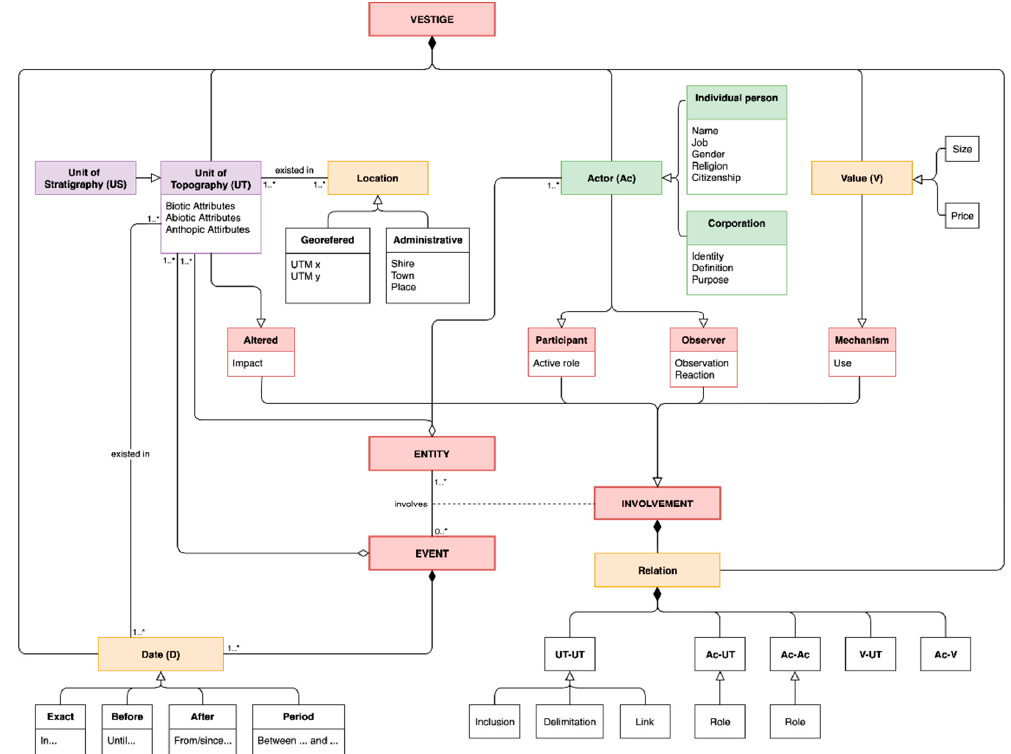
Figure 2. UML diagram expressing the minimum information units of historical knowledge as components of Vestige. This conceptual modeling fits well within Thibodeau’s CPT, whose classes are highlighted in red. Our further concept development is highlighted in purple for UT, green for Ac and orange for relational classes.